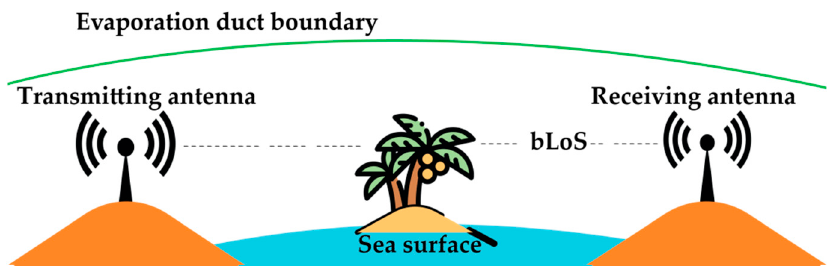
Figure 6. An example of a beyond non-line-of-sight (bLoS) propagation pathway.